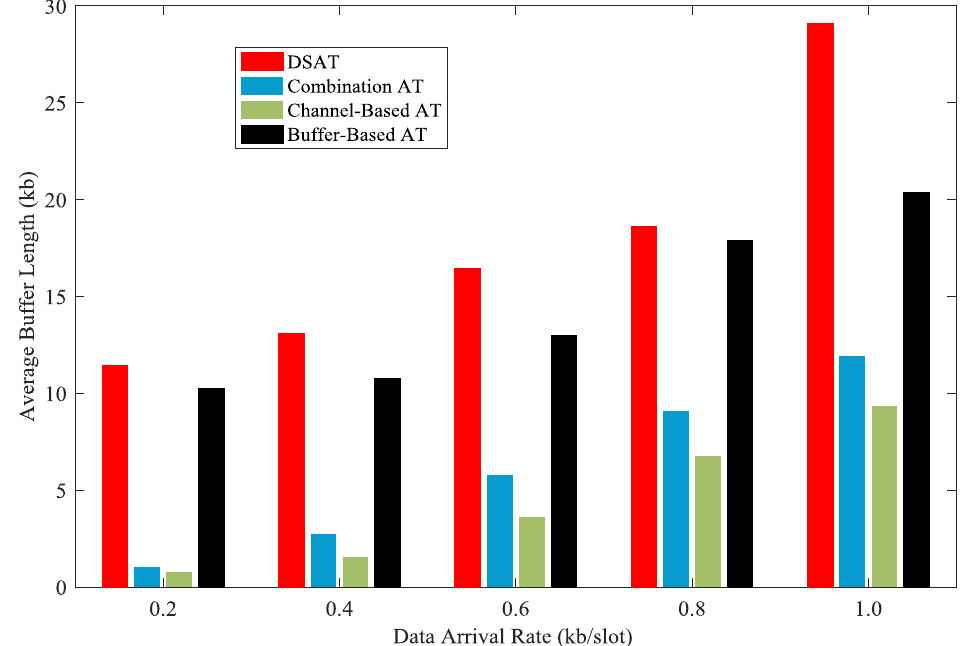
Figure 25. Average buffer length for comparative strategies (Data